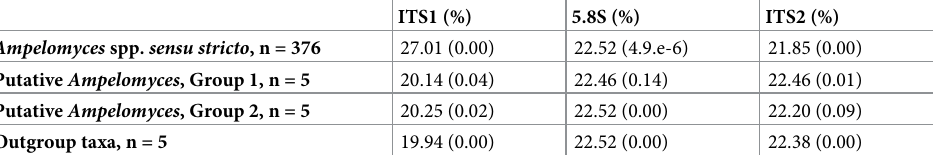
Table 3. The maximum normalized sequence lengths of the 5.8S gene and ITS2 spacer were conserved among all fungal